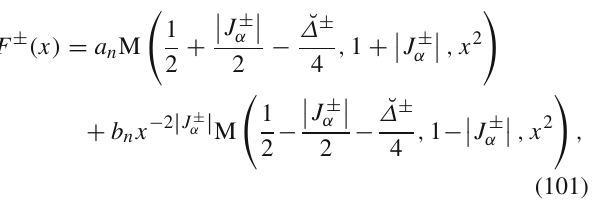
with n (cid:10) = 0 , 1 , 2 , 3 , ... , where (cid:23) (cid:22) (cid:3) (cid:2) 2 ˘ 2 − M 2 + 2 M ω = (cid:20) ± k ± nm of the oscillator are obtained. Since V ( r ) = S ( r ) =